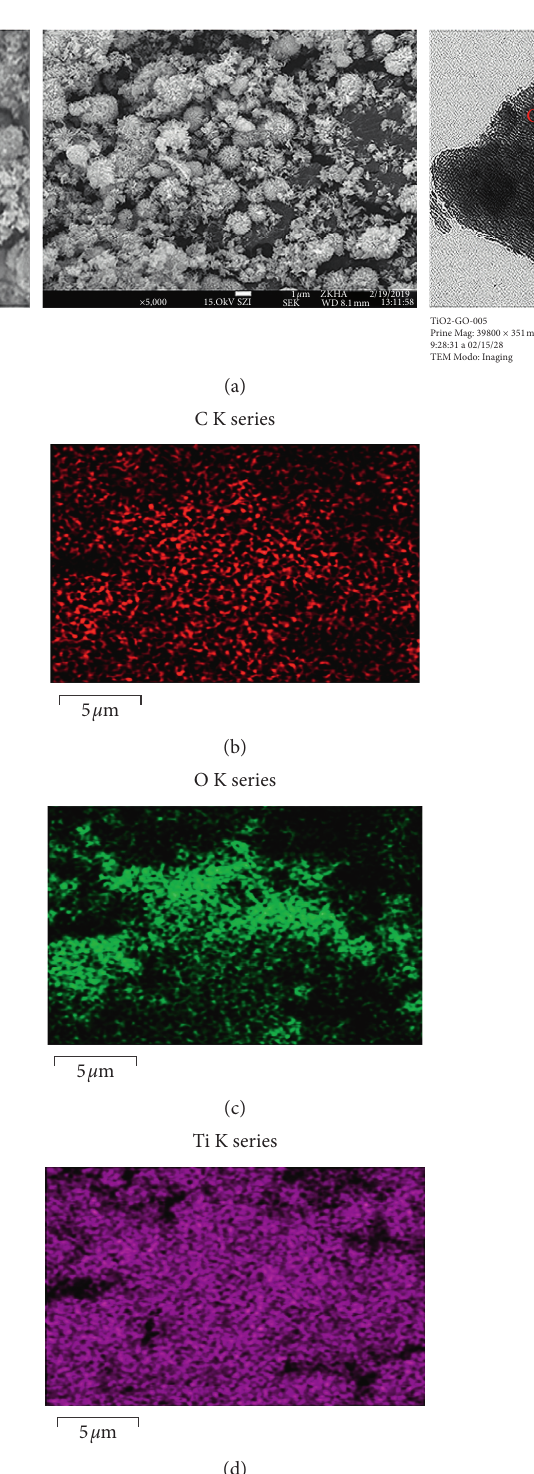
2 nanocomposite